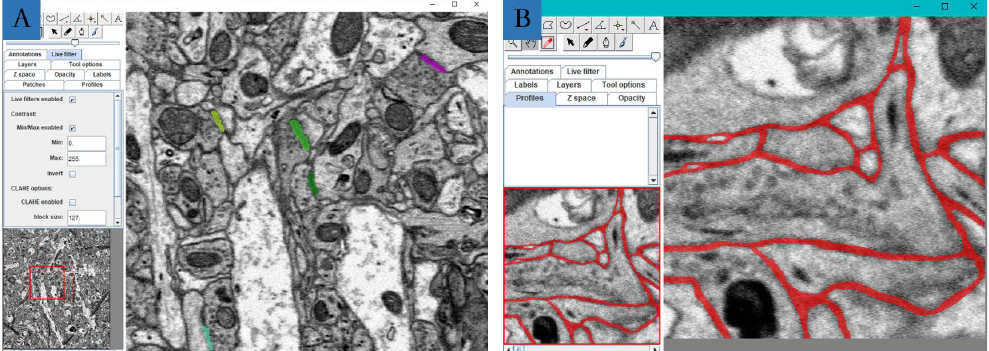
Figure 2. Interface of FIJI for labeling the ground truth. ( A ) Interface of FIJI for labeling synapse; ( B ) interface of FIJI for labeling neuronal